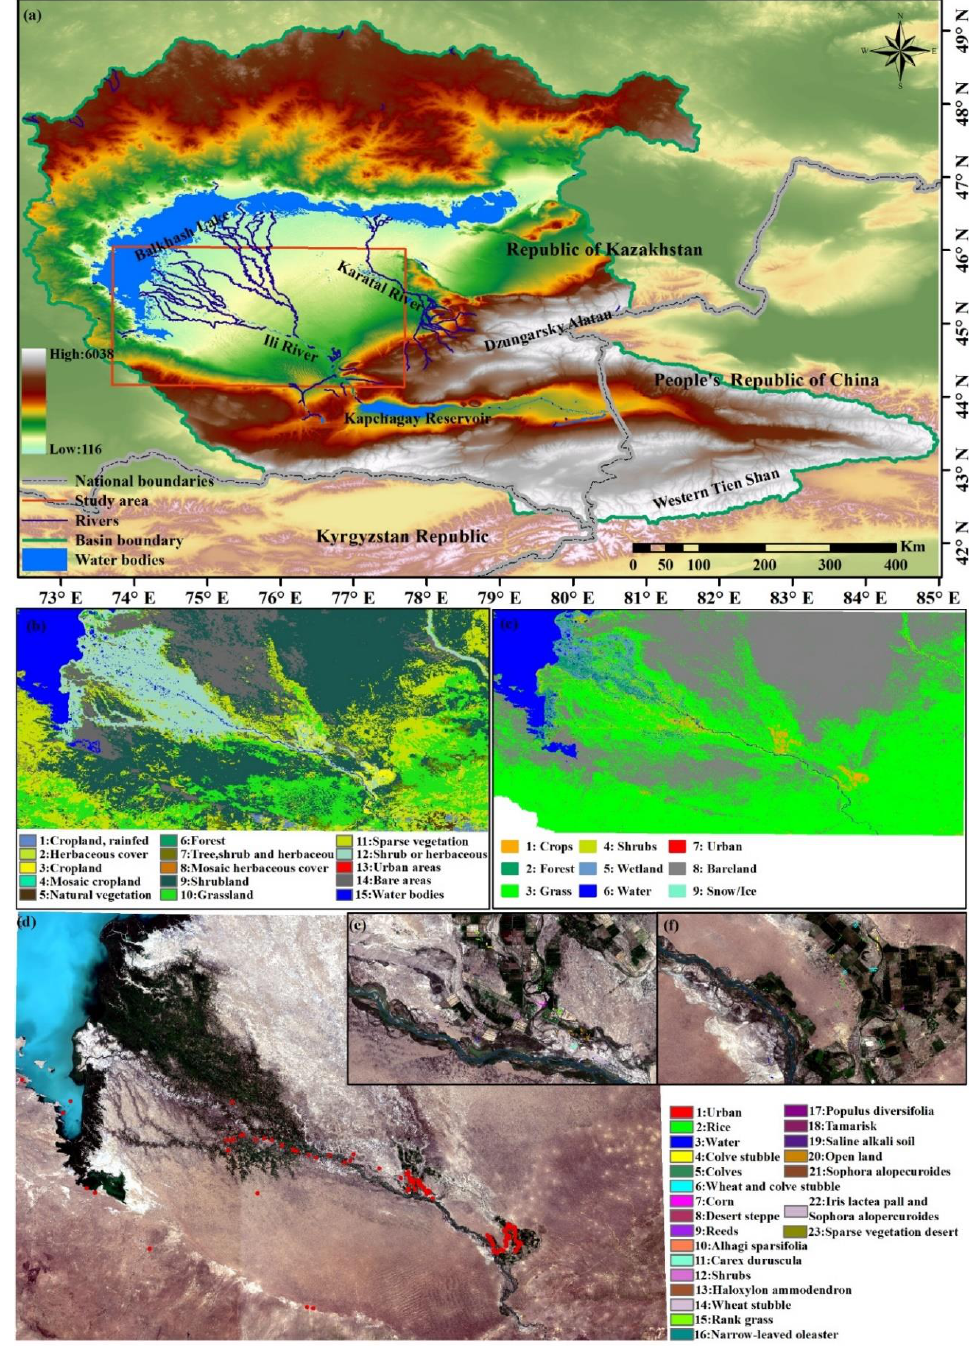
Figure 1. ( a ) Geographic location of the study area, ( b ) 2015 Moderate Resolution Imaging Spectroradiometer land use and cover change (MODIS LUCC), ( c ) 2017 GLC30, ( d ) blue rectangle, ( e ) blue rectangle, and ( f ) green rectangle. Sentinel-2 RGB image of the study area with in situ points (red dots) and the corresponding land cover